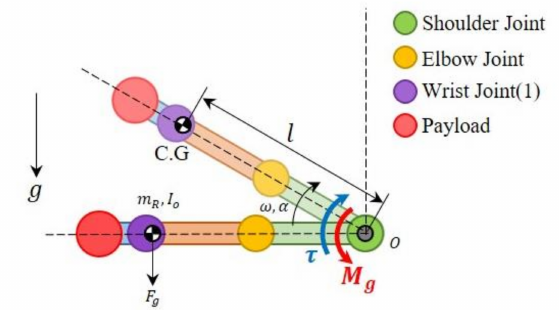
Figure 4. Free body diagram for situations where maximum torque is required for a joint.